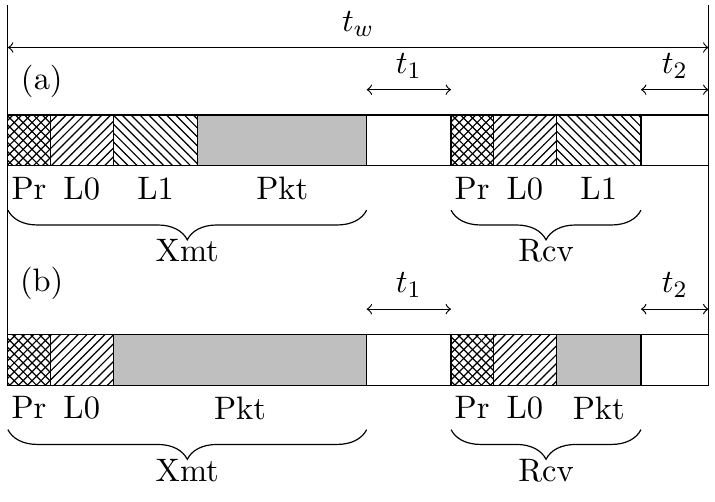
Figure 6. TDD frame structure: ( a ) Link establishment and adjustment phase; and ( b ) data transfer phase (with ARQ possible in one direction